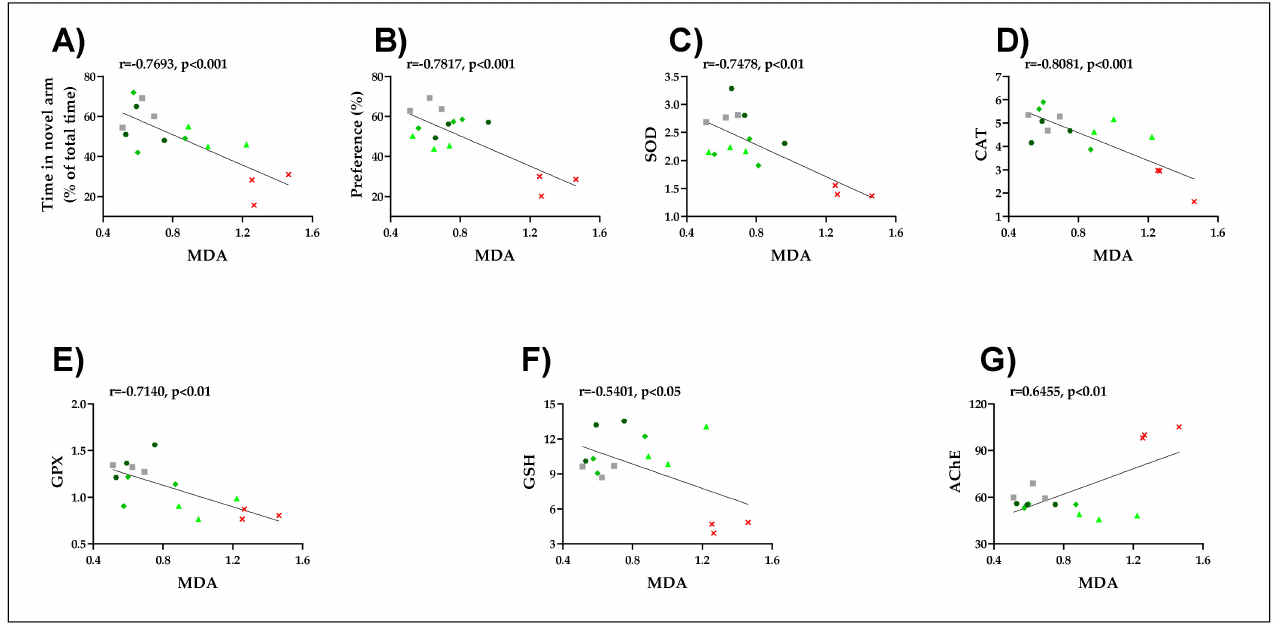
Figure 8. Correlation analyses between behavioral and biochemical parameters (Pearson’s correlation, n = 10): ( A ) Time in novel arm (% of total time) vs. MDA: r = − 0.7693, p < 0.001; ( B ) Preference vs. MDA: r = − 0.7817, p < 0.001; ( C ) SOD vs. MDA: r = 0.7478, p < 0.01; ( D ) CAT vs. MDA: r = − 0.8081, p < 0.001; ( E ) GPX vs. MDA: r = − 0.7140, p < 0.01; ( F ) GSH vs. MDA: r = − 0.5401, p < 0.05; ( G ) AChE vs. MDA: r = − 0.6455, p < 0.01. Data expressed are time in the novel arm (% of total time), time in the novel arm (s), SOD (U/mg protein), CAT (U/mg protein), GPX (U/mg protein) GSH ( µ g GSH/ µ g protein), AChE (nmol/min/mg protein), and MDA (nmol/mg